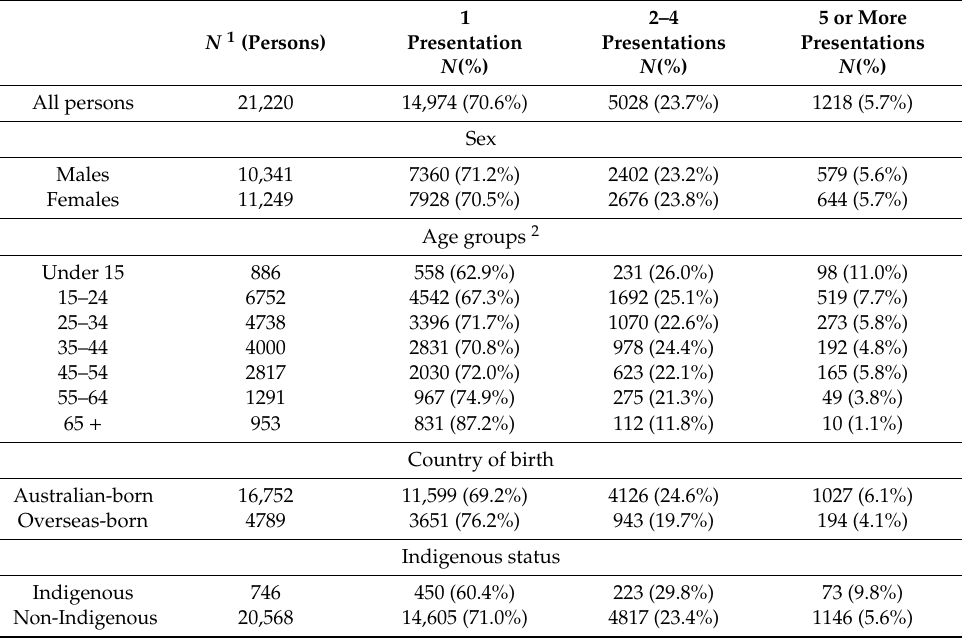
Table 2. Frequency of suicidal presentations per person,